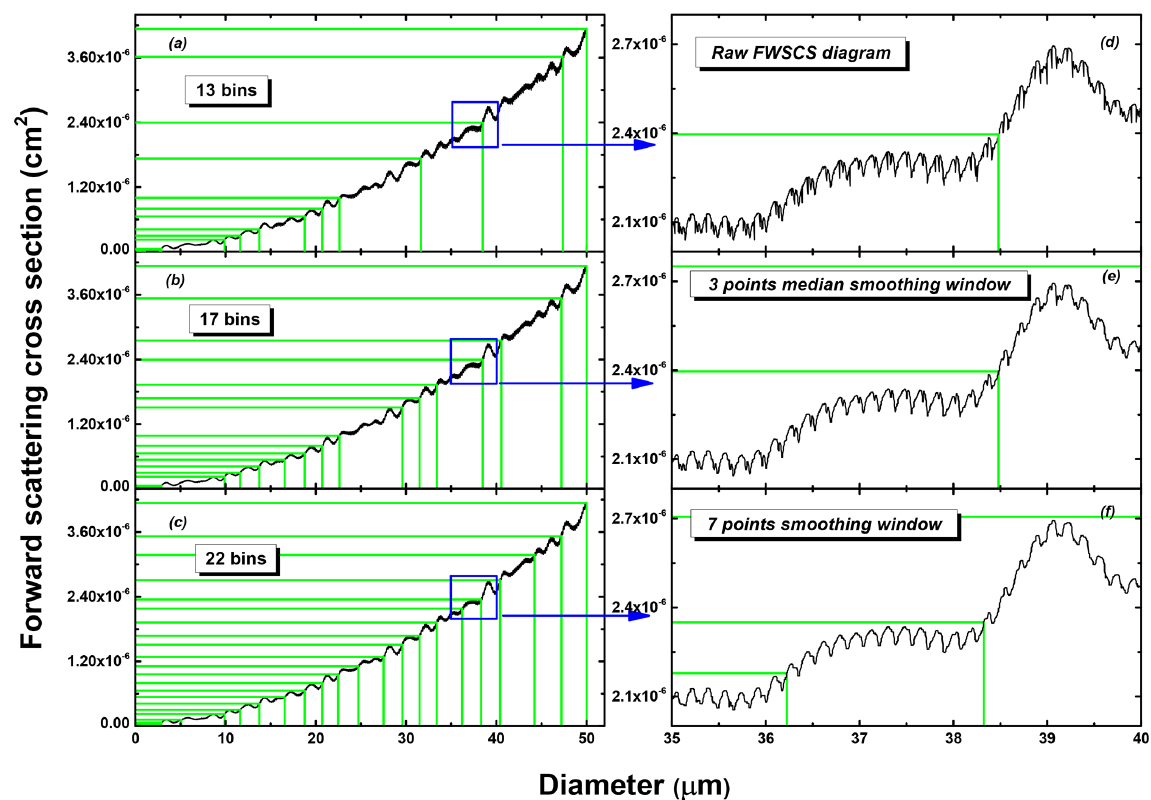
Figure 2. Size and FWSCS bin structures induced on the FWSCS-diameter diagram. Green lines in panels (a) , (b) and (c) indicate the size bins (on the abscissa) and the FWSCS bins (on the ordinate), for three degrees of smoothness, as indicated in panels (d) , (e) and (f) , where one same detail of the diagram is magnified for